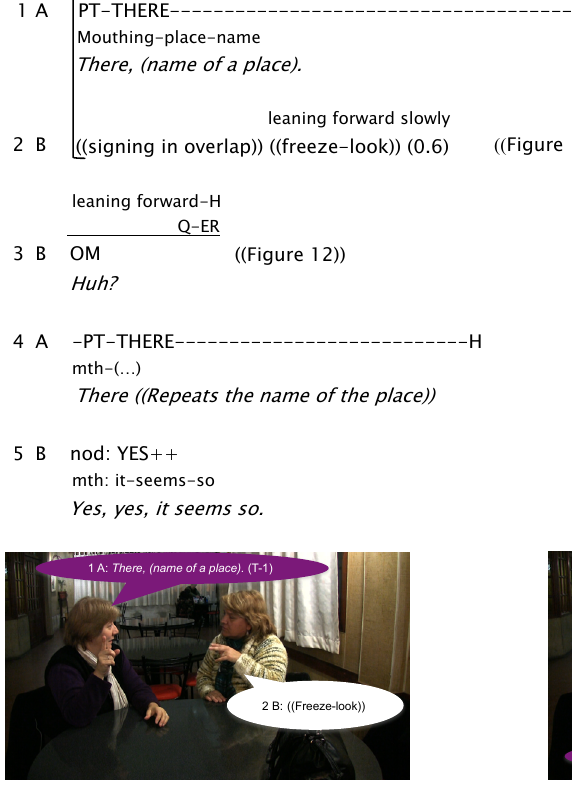
Figure 12. ‘Huh?’ , Person B, on the right, initiates repair by opening her mouth, accompanied with leaning forward and a hand retraction of the previous held sign, line 3